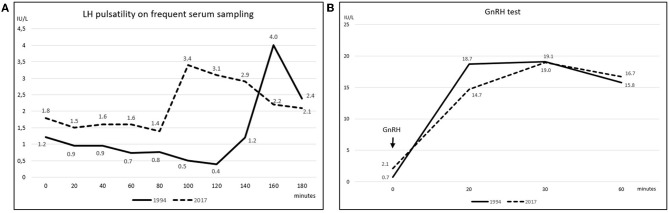
(A) Spontaneous LH pulsatility assessed by frequent serum sampling. The graph depicts LH pulsatility assessed at the patient's first referral in 1994 (solid line) and upon hypogonadism symptoms' manifestation in 2017 (dashed line) (LH reference values 1.7–8.6 IU/L); gonadotropin's levels were measured at 20-min intervals for 3 consecutive hours; secretion still occurred in a pulsatile fashion at both time points; nevertheless, as far as one single LH peak was evaluated, the LH release profile appeared slightly flatter in 2017 compared to the 1994 assessment. (B) LH response to GnRH stimulation test. GnRH stimulation test was performed in 1994 (solid line) and then repeated in 2017 (dashed line). Blood was drawn before, and then 20, 30, and 60 min after intravenous GnRH administration; a ≥400% increase from baseline was considered normal (16). LH curves were similar at the two time points and both responses resulted normal, as levels increased by 26 folds in 1994 and by 8 folds in 2017.